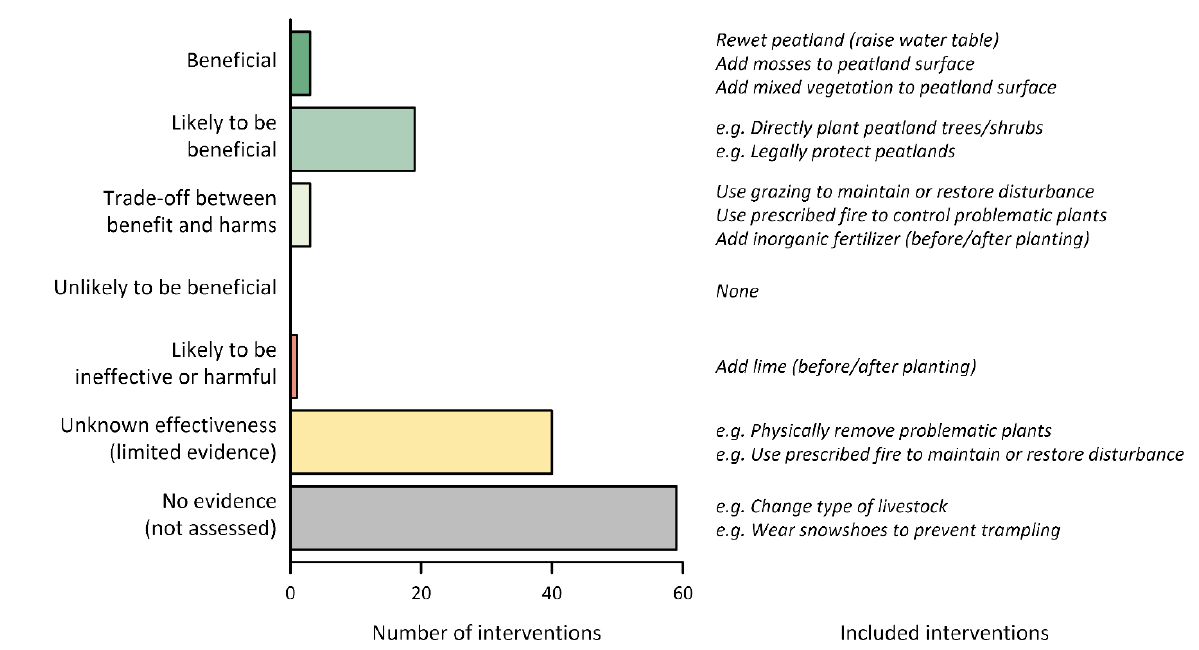
Figure 5. Number of interventions (total = 125) in each overall effectiveness category, based on expert assessment of effectiveness, certainty and harm ( n = 13 experts). Scores were based solely on the collated evidence from the published literature. Effectiveness categories reflect the likely effects of interventions in all relevant habitat types. Thus, for a beneficial intervention there is clear evidence to suggest benefits to peatland vegetation in all peatland habitats where one might realistically carry out the intervention. See Sutherland et al. (2018) for further information about effectiveness